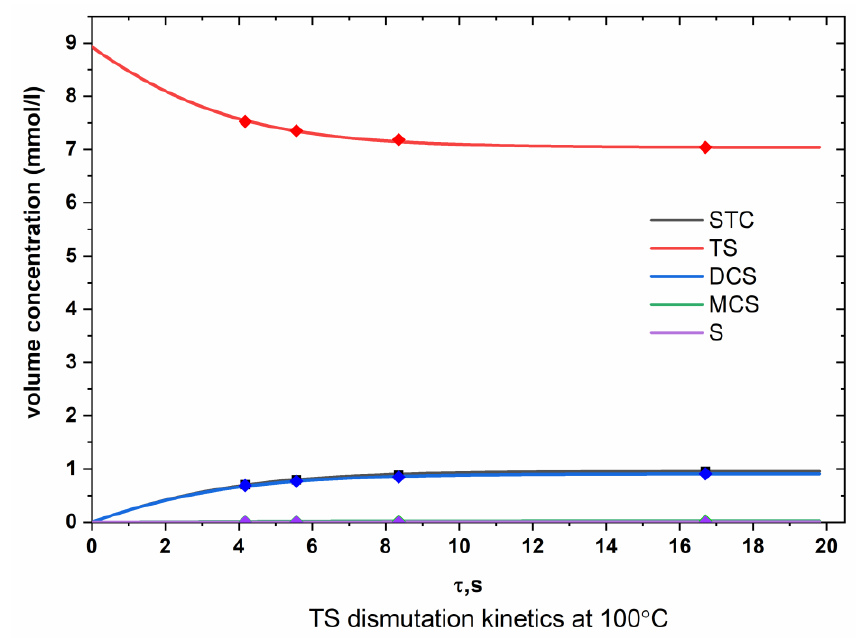
Figure A2. Dependence of the molar concentrations of chlorosilanes on time (TS, 100 °C).